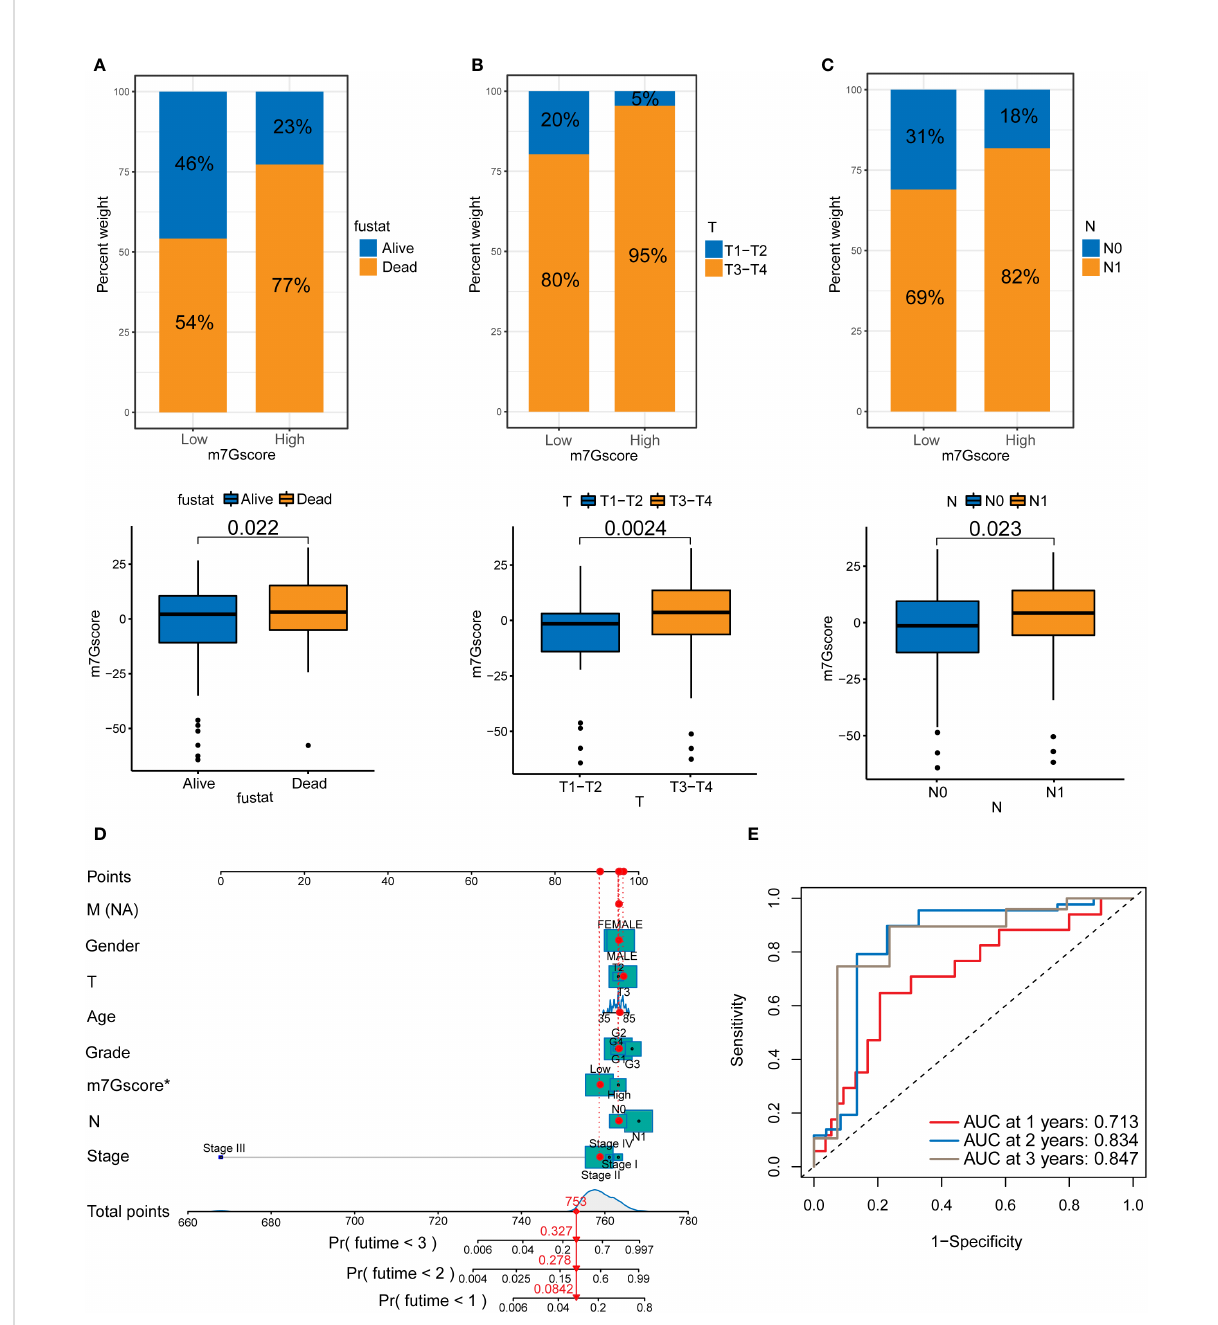
FIGURE 4 The relationship between m7G scores and prognosis in PDAC. (A) Survival in the high and low m7G score groups. (B) T staging of the high and low m7G score groups. (C) N staging of the high and low m7G score groups. (D) NOMO map associated with m7G score and clinical information. (E) Area under the curve (AUC) for time-dependent receiver operating characteristic curves demonstrating the prognostic performance of the NOMO